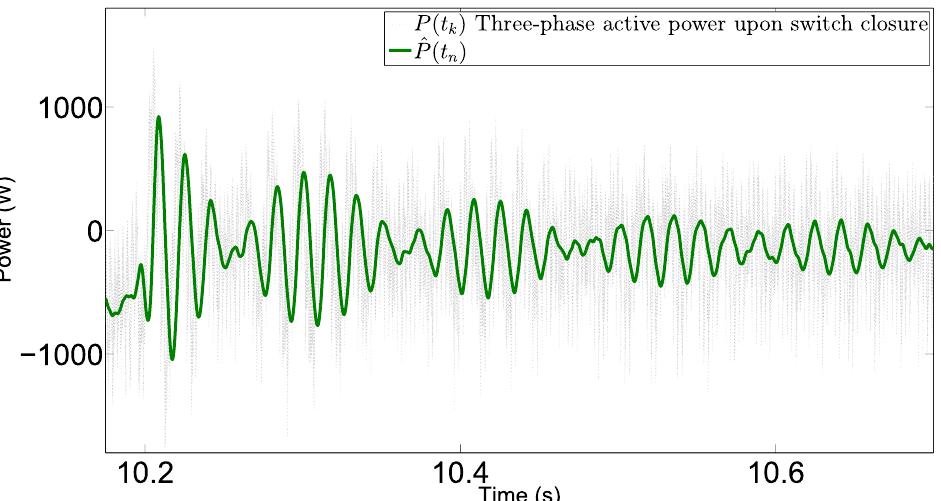
Figure 5. Actual real-time measured three-phase active power compared to the filtered three-phase active